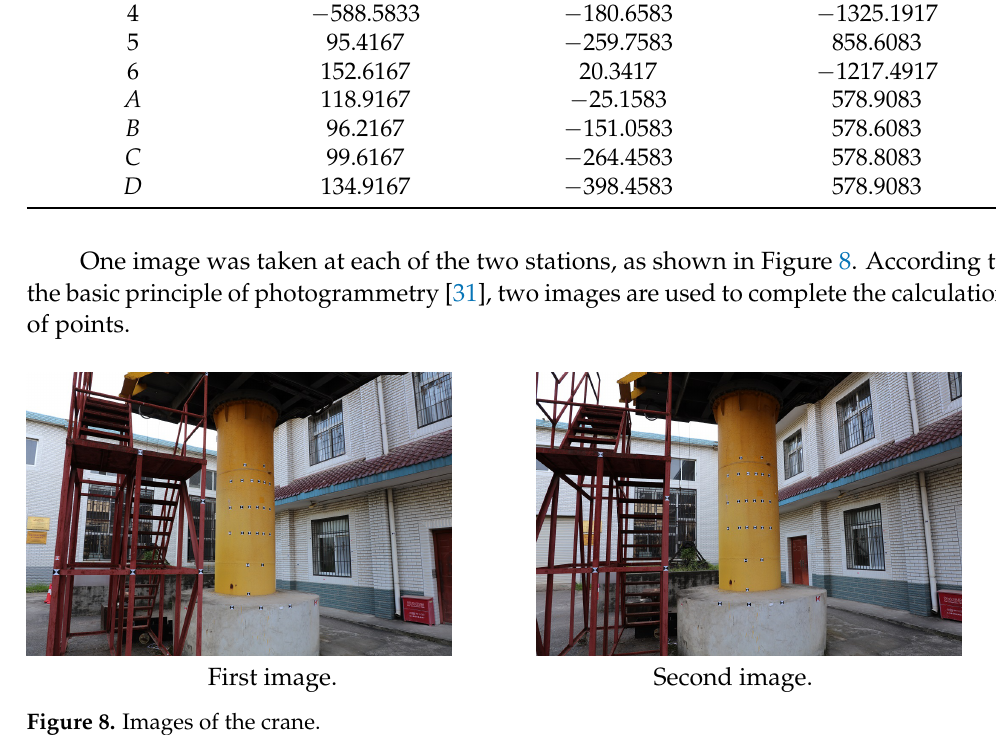
Figure 8. Images of the crane.